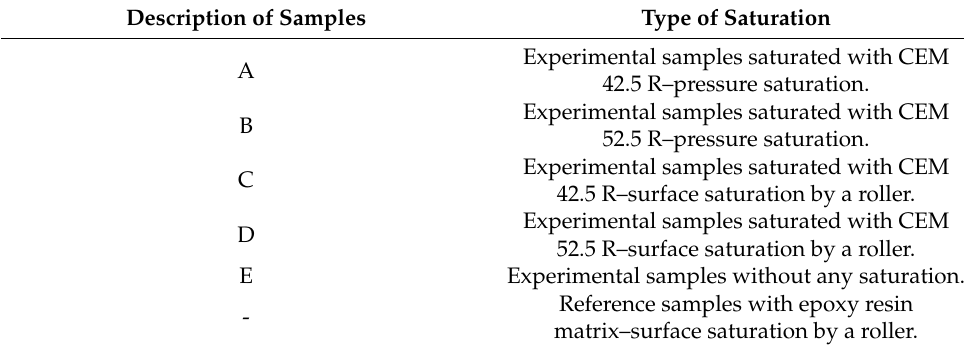
Table 3. Variants of experimental